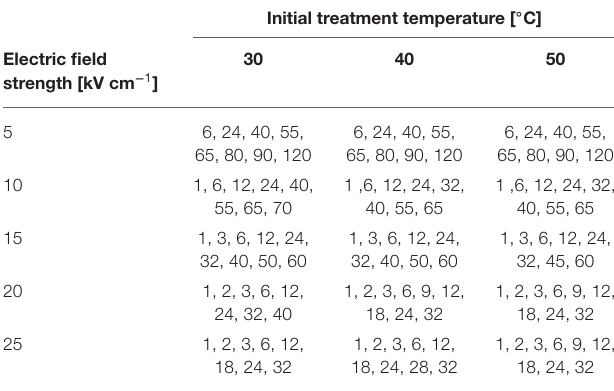
TABLE 2 | Number of pulses applied to the sample for different pulsed electric field (PEF)